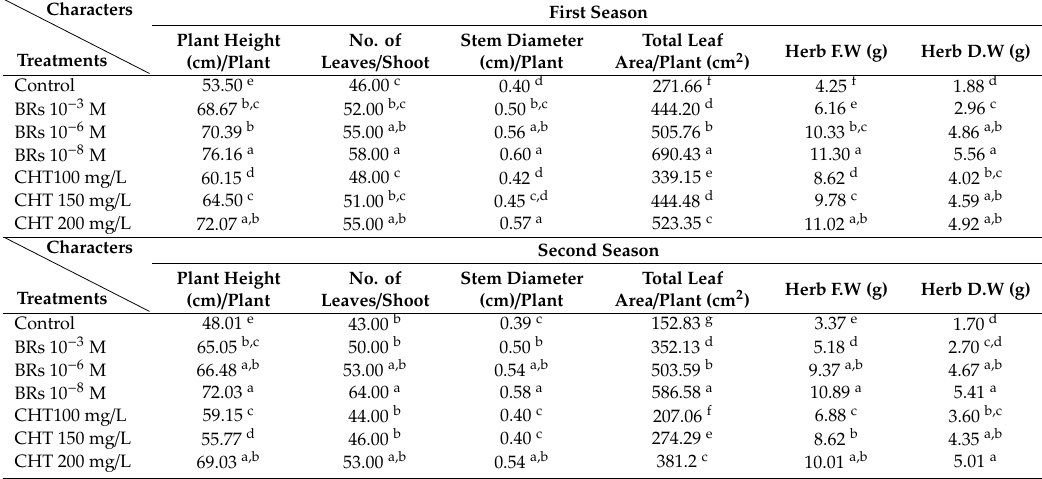
Table 3. E ff ects of di ff erent concentrations of brassinosteroids and chitosan on the morphological characteristics of Solidago canadensis cv. Tara plants during 2018 and